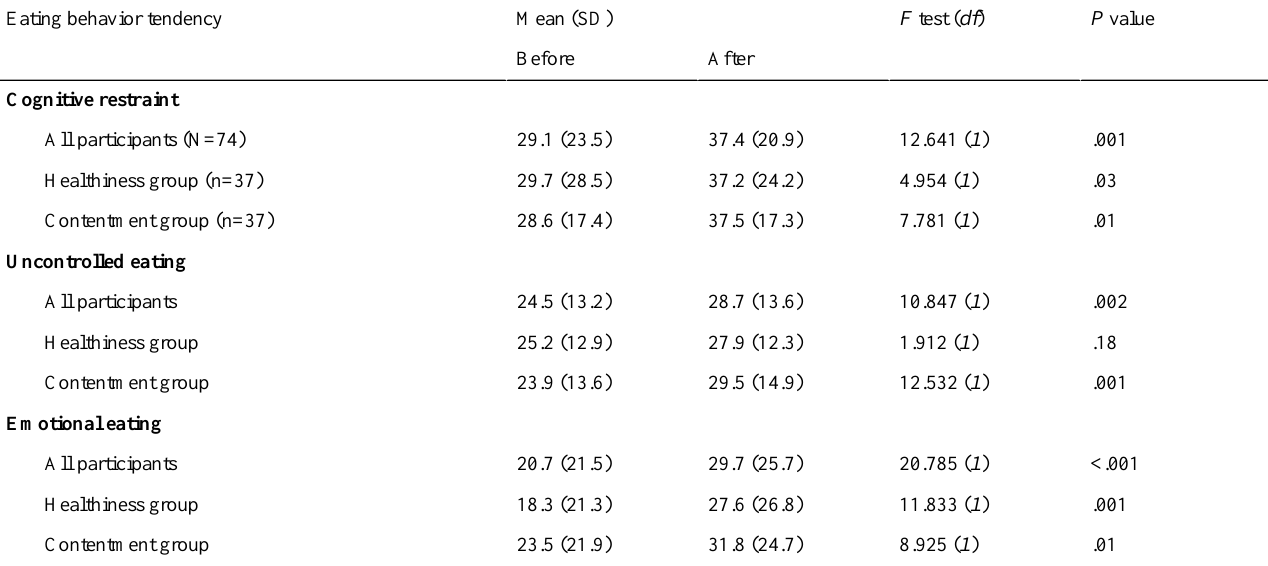
Table 4. Participants’ (all participants and subgroups) responses to the three-factor eating questionnaire R15 (mean, SD, scale 0-100, in which higher score means greater tendency toward the measured subscale) before the intervention and after the